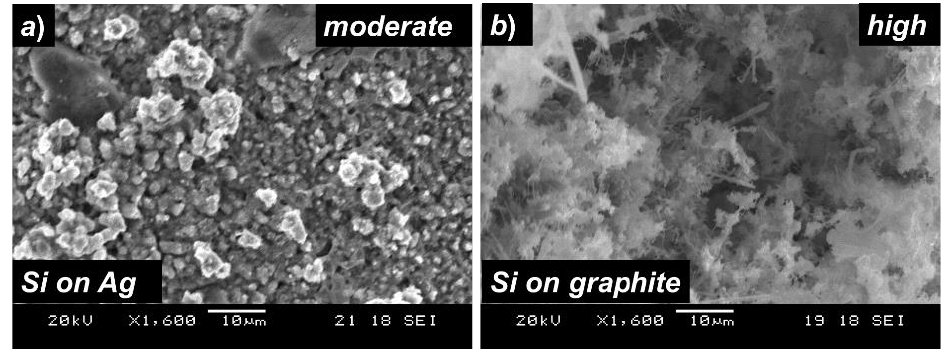
Figure 4. ( a ) SEM image of the electrochemically deposited Si films on a silver substrate obtained with applying reduction potential equivalent to moderate potential ( b ) SEM image of the electrochemically deposited Si films on graphite substrates from the reduction of larger-sized SiO 2 particles, and with applying reduction potential equivalent to high potential .